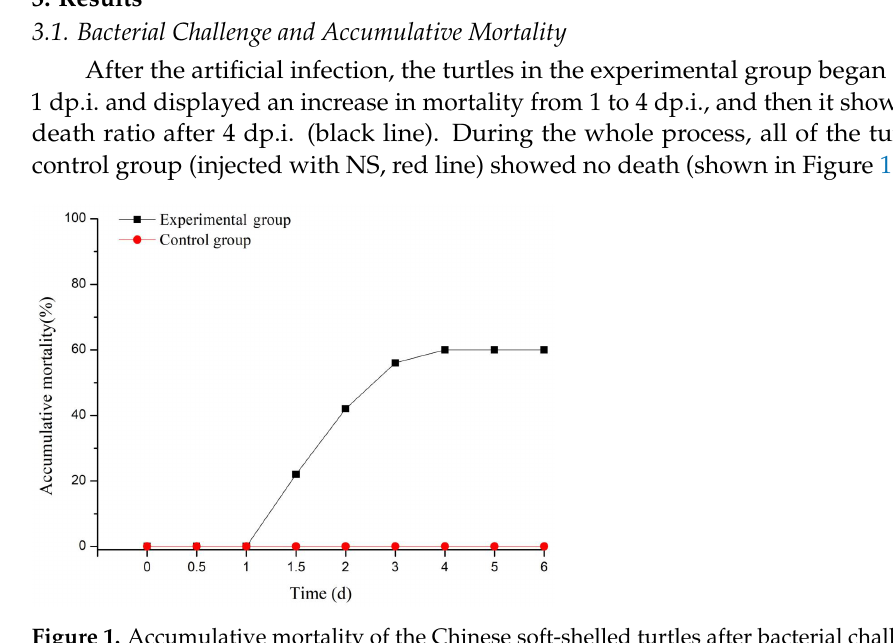
Figure 1. Accumulative mortality of the Chinese soft-shelled turtles after bacterial